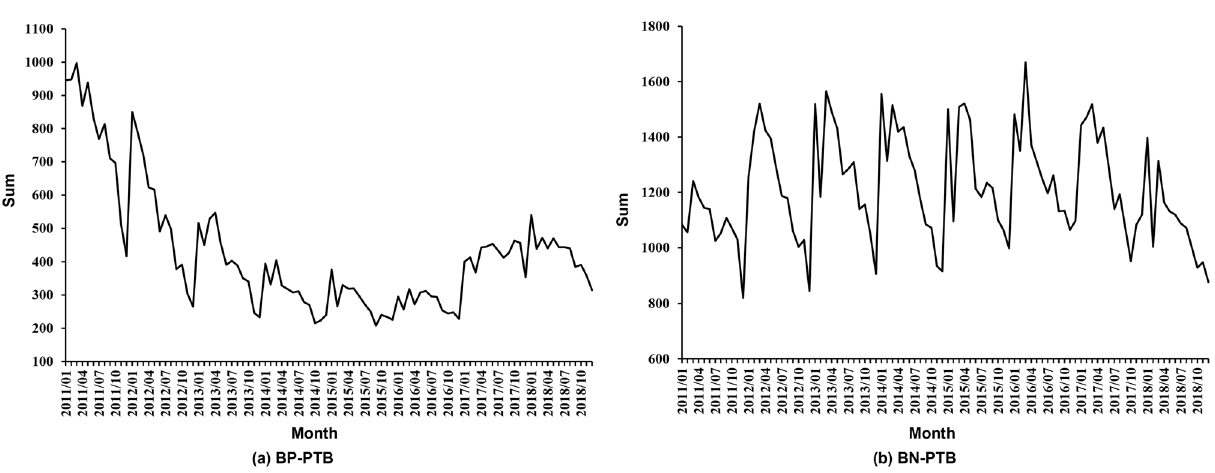
Figure 2. The monthly distribution of BP-PTB cases and BN-PTB